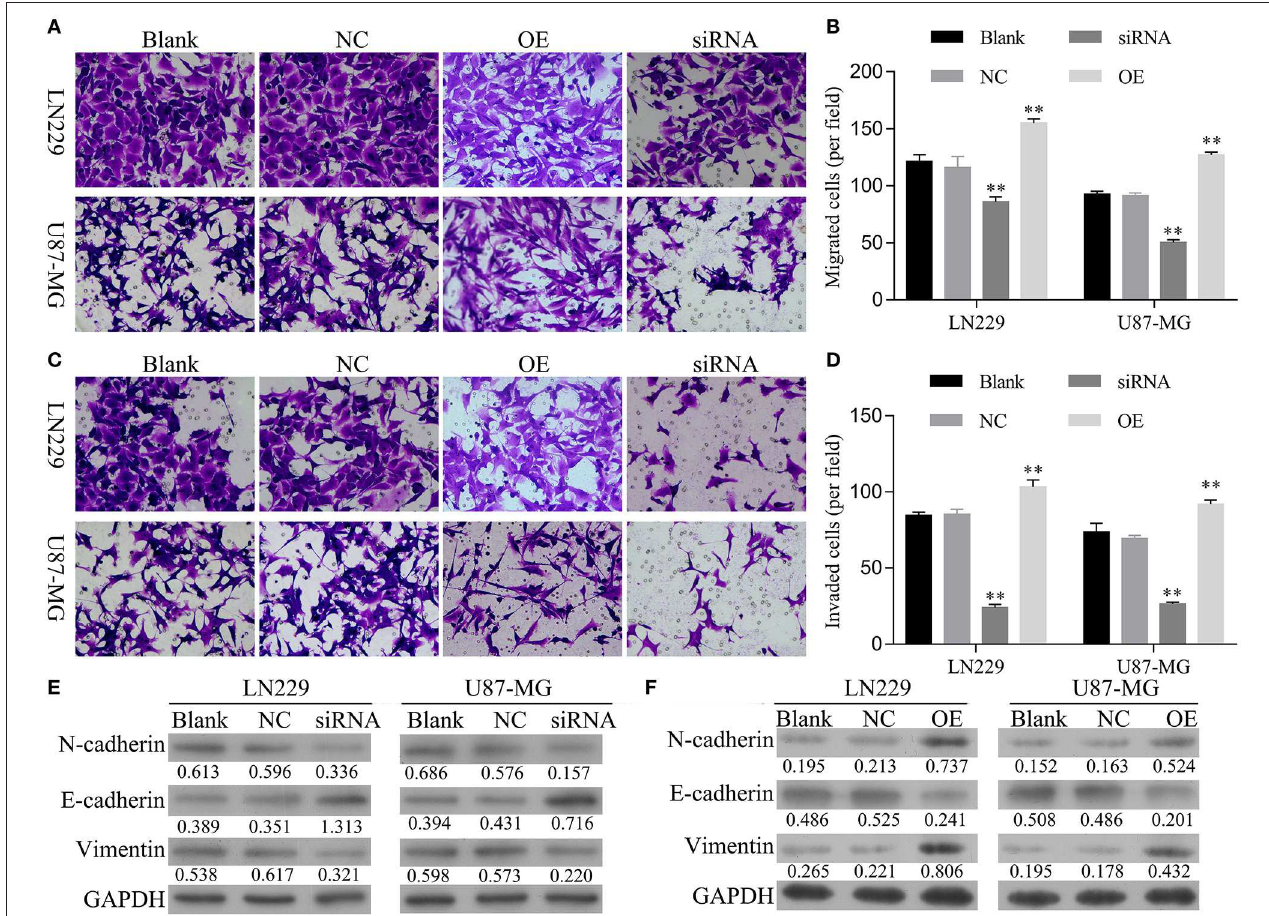
FIGURE 3 | hsa_circ_0088732 regulated glioma cell migration, invasion, and epithelial-mesenchymal transition (EMT). (A–D) The effect of hsa_circ_0088732 knockdown or overexpression on cell migration and invasion was evaluated by Transwell assays. (E,F) The expression of EMT-related proteins (E-cadherin, N-cadherin, and vimentin) was examined by western blotting. NC: negative control, siRNA: hsa_circ_0088732 siRNAs, OE: hsa_circ_0088732 overexpression plasmids.